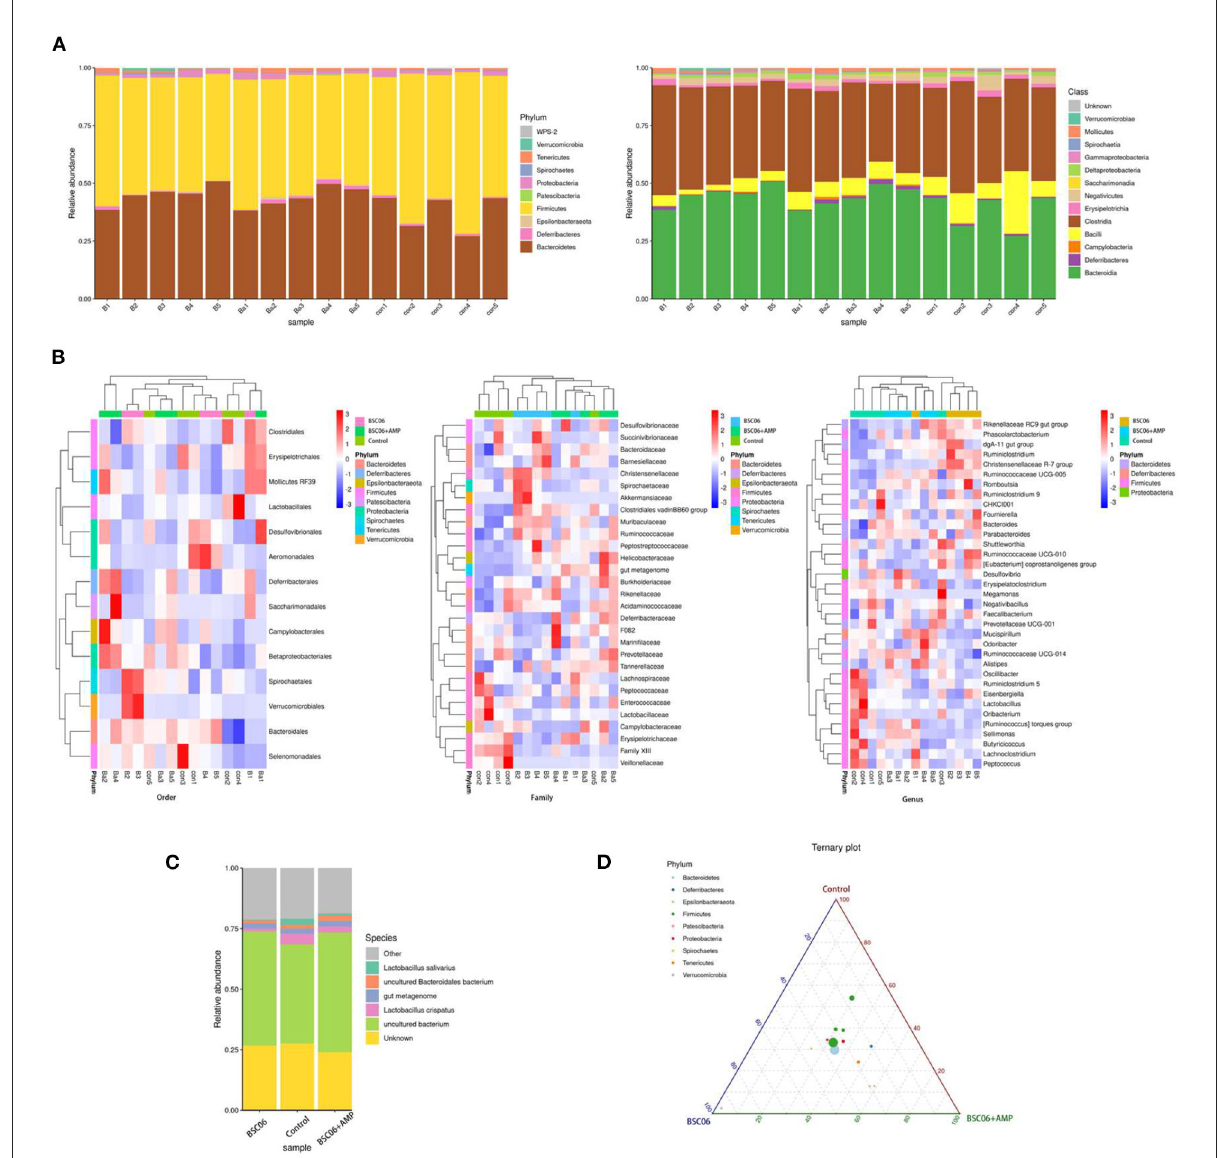
FIGURE5 Bacterial taxonomic composition of cecum contents. (A) Relative abundance of phylum and class level. (B) Highest relative abundance in the different groups of Order, Family and Genus level. (C) Relative abundance of Species. (D) Distribution of the different class in the three groups, the size of the points represents the average abundance of the class, and the color of the points represents the phylum from which the class is derived.